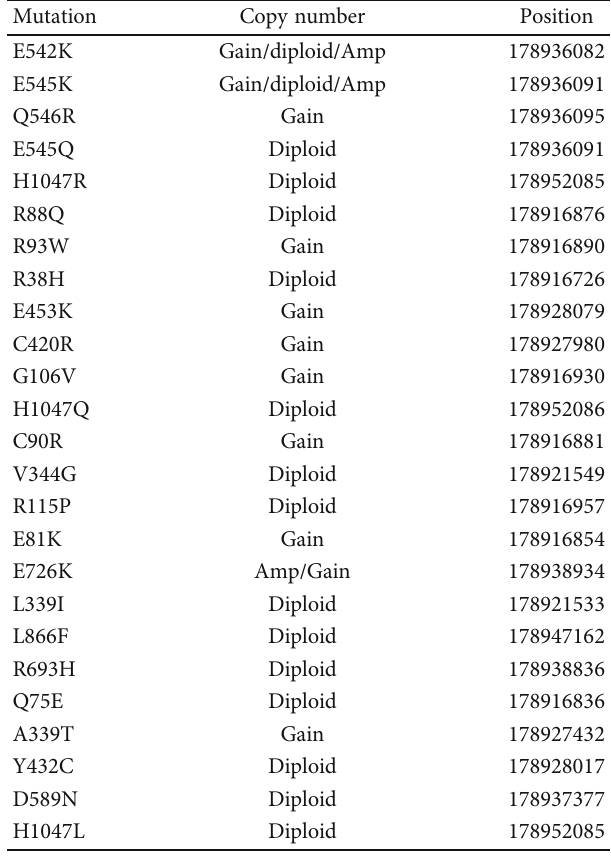
Table 1: PIK3CA missense mutations show the amino acid change in the cervical squamous cell carcinoma ð n = 25 Þ